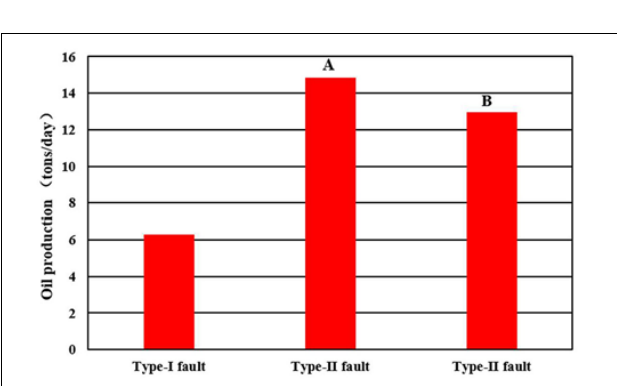
FIGURE 9 | The oil production in the wells drilled different scale of fault. (A) Cutting the fault of Chang 7, with a larger fault scale; (B) Cutting the fault of Chang 8, with a smaller fault scale.